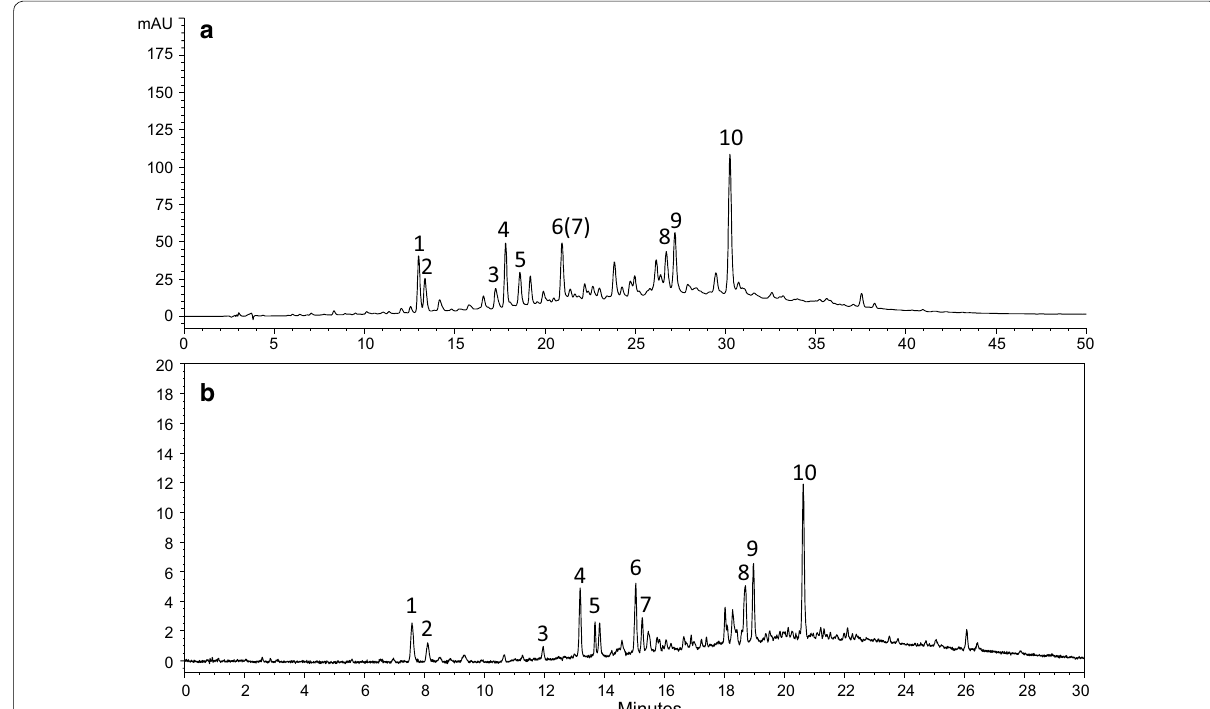
Fig. 2 Resina Draconis (sample 12) on conventional HPLC and UPLC at 280 nm: HPLC ( a ); UPLC ( b ). Peak 1 resveratrol; Peak 2 7,4 ′ -dihydroxyflavone; Peak 3 loureirin A; Peak 4 loureirin B; Peak 5